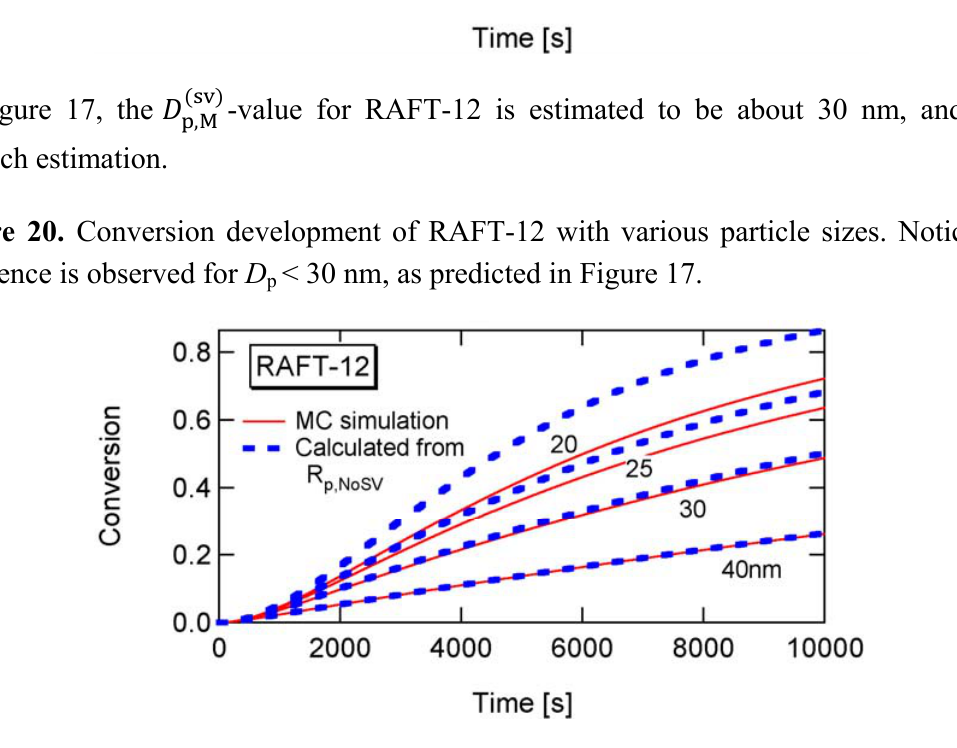
in nanometer. Noticeable difference is observed p